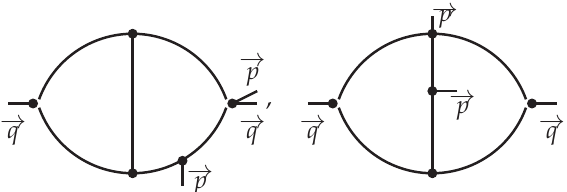
Figure 3. The diagrams J 1 ( α = 1, q , p ) and J 2 ( α = 1, q , p )